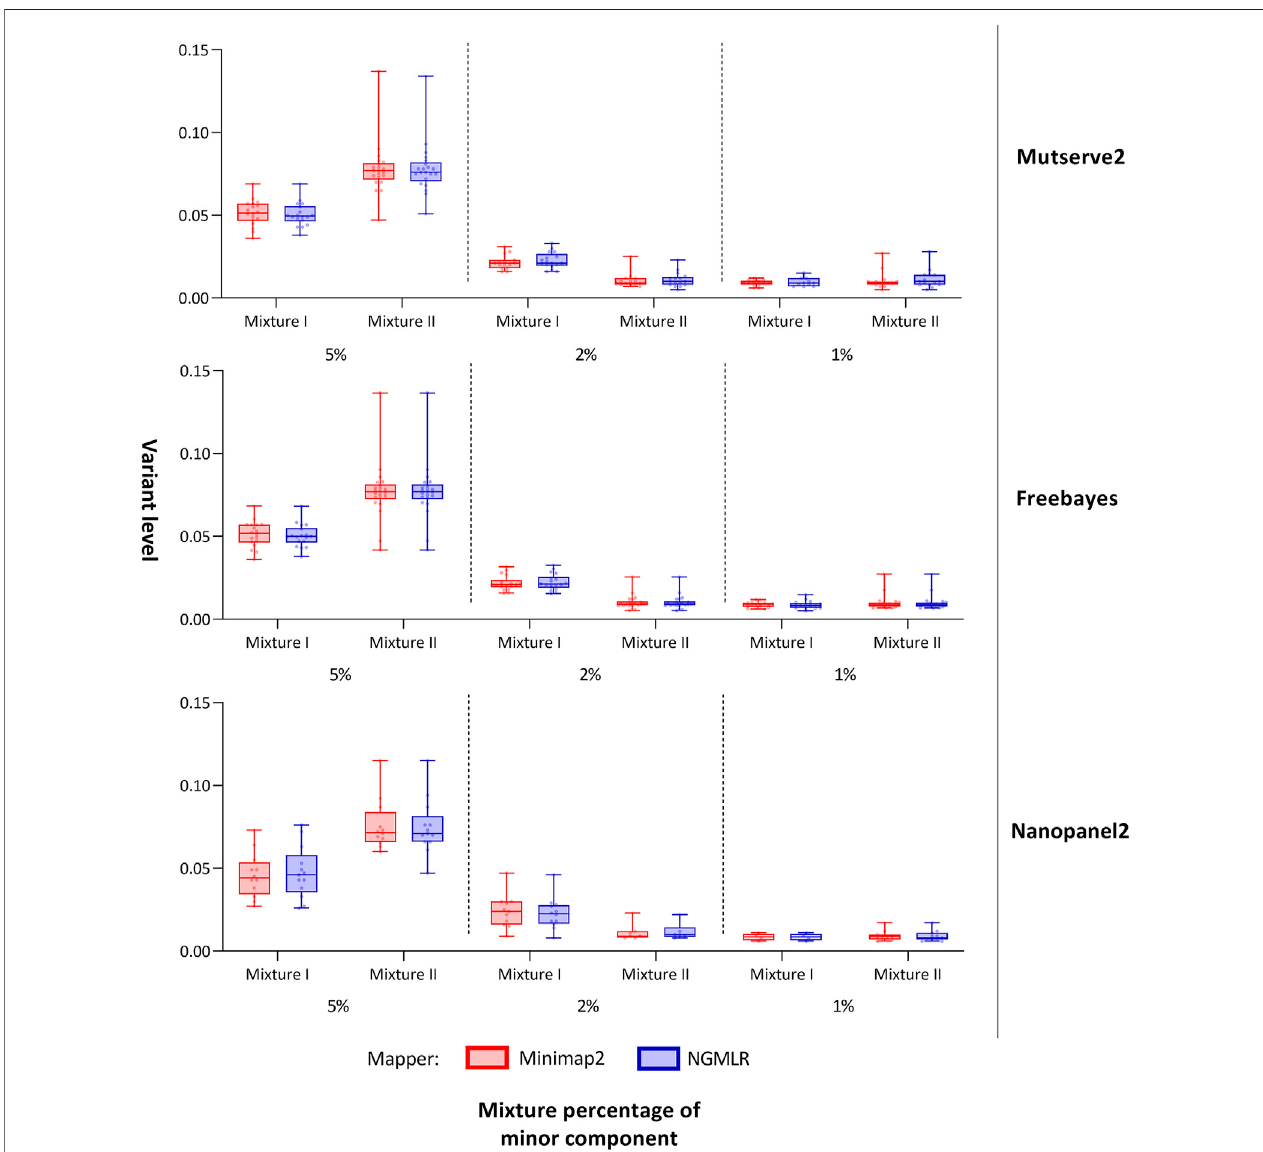
FIGURE 3 | Allele frequency of variants detected from the mitochondrial DNA nanopore data. Box plots show the allele frequency of the mitochondrial minor variants detected with two aligners (i.e., Minimap2 and Ngmlr) and the three variant callers (i.e., Mutserve2, Freebayes, and Nanopanel2). The bars and whiskers represent the median, the interquartile range, and the minimum and